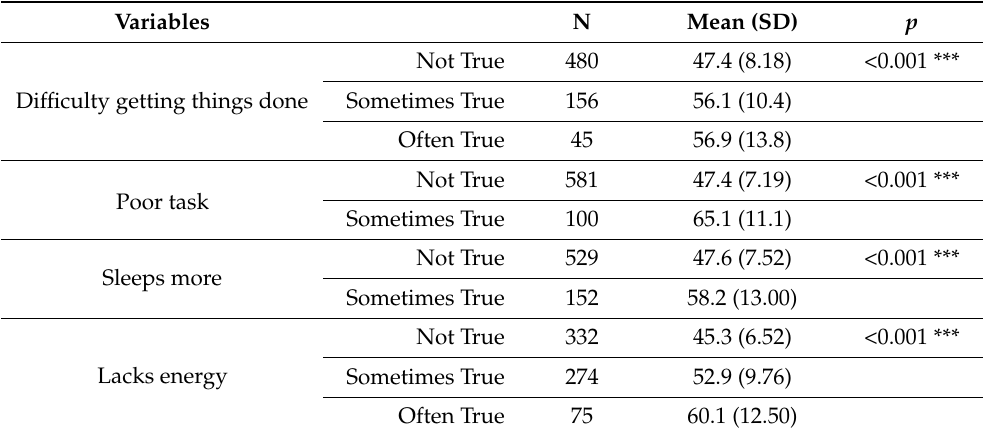
Table A1. Means of SCD Grouped by Age, Gender, and Mental Fatigue